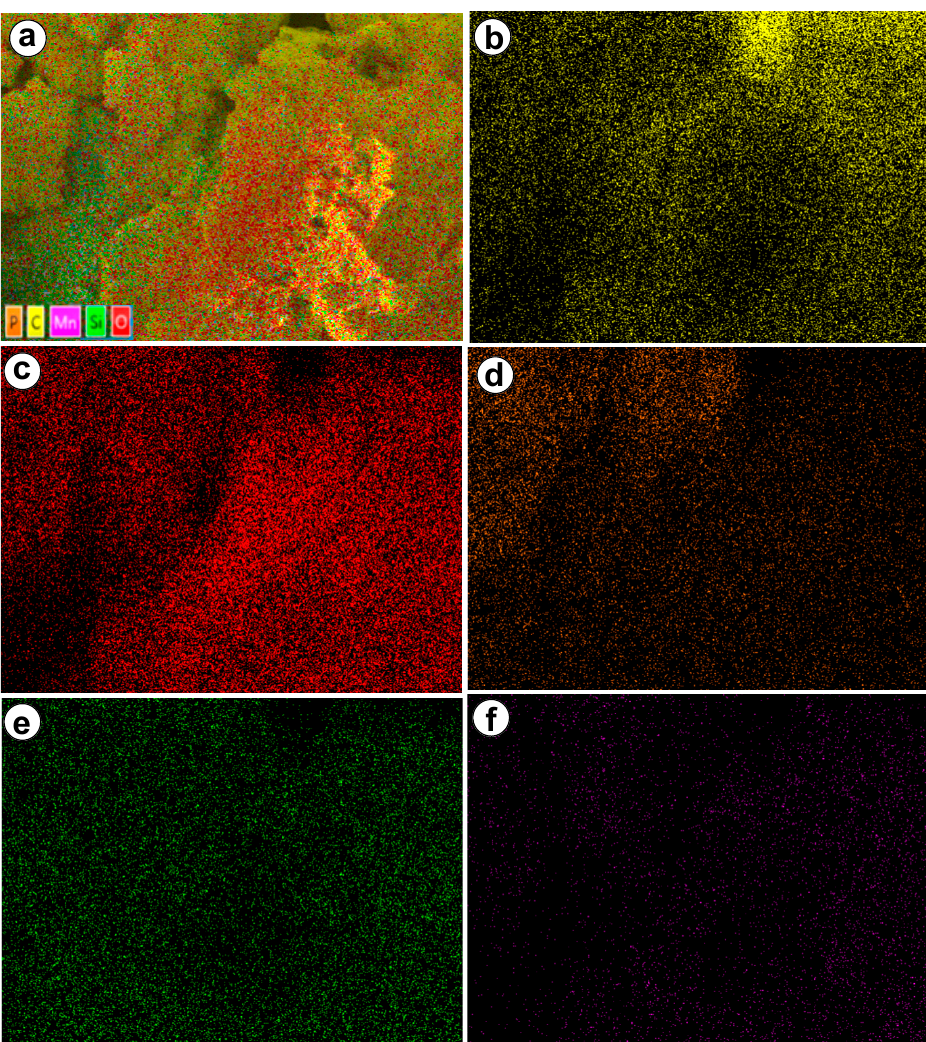
Figure 5. EDX elementary mapping of ( a ) layered image of catalyst 2, ( b ) C, ( c ) O, ( d ) P, ( e ) Si, and ( f ) Mn in catalyst 3.